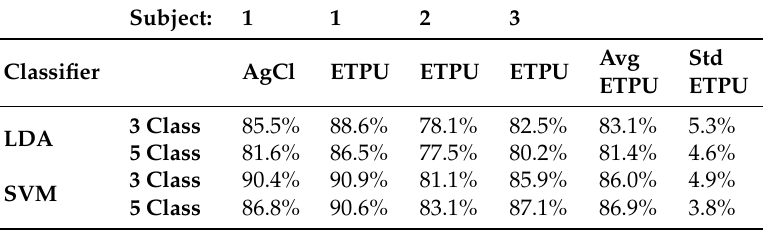
Table 3. Classification accuracy of each classifier.